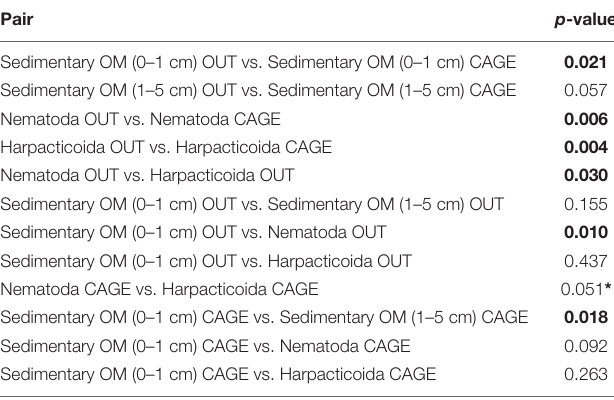
TABLE 1 | Student t -test (2 tailed) comparing δ 13 C differences between pairs from Figure 3 . Pair p